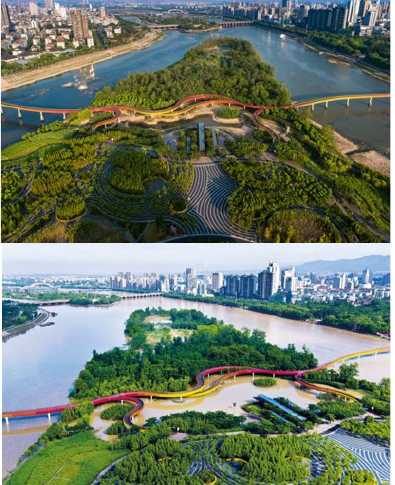
Figure 6. The view of Yanweizhou Park during the dry season on the left, wet season on the right. Source: (Toh, 2018).